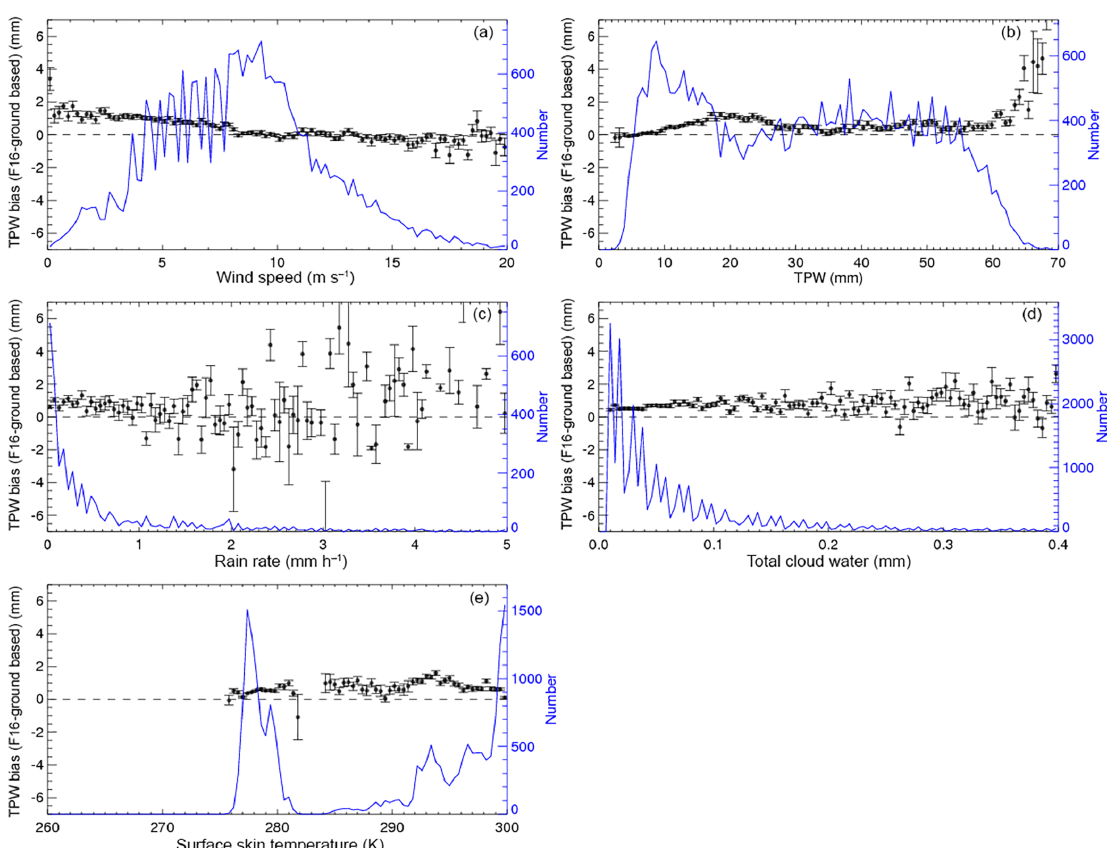
Figure 6. Mean and standard of the mean for the F16 gb-GPS TPW biases varying with (a) wind speed (ms − 1 ), (b) TPW (mm), (c) rain rate (mmh − 1 ), (d) total cloud water (mm), and (e) surface skin temperature (K). The vertical black bracket superimposed on the mean denotes the standard error of the mean. The green dashed line is the number of samples, indicated by the scale on the right.